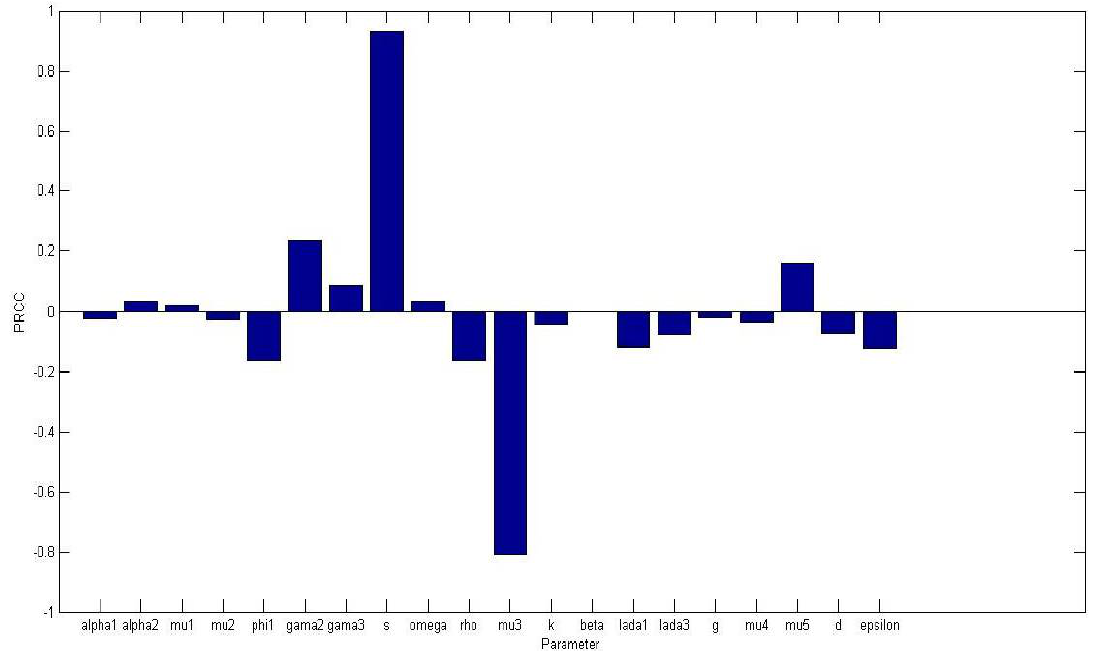
Figure 1. PRCCs of homogeneous model parameters with the tumor cells as the baseline variable. All parameter values were varied in 25 % of their baseline values in Table 1. The most sensitive parameters are shown to be valuesP  of 311 ,,,  g and  are less than 0.01.